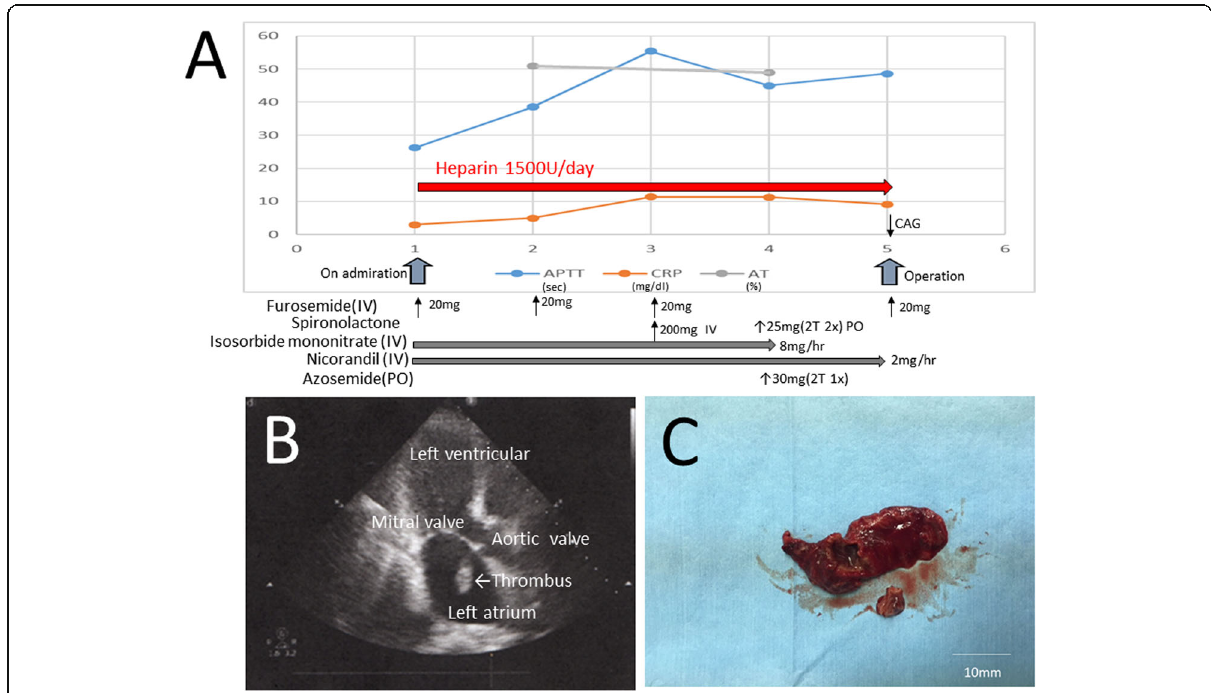
Fig. 1 a Trends of activated partial thromboplastin time (APTT), CRP (C-reactive protein level), AT (antithrombin), heparinization, and other medications before surgery ( x -axis, days; y -axis, measurement values). CAG coronary angiography, IV intravenous, PO per os. b Two-dimensional TTE immediately before surgery. c Removed thrombus attached at the left atrial